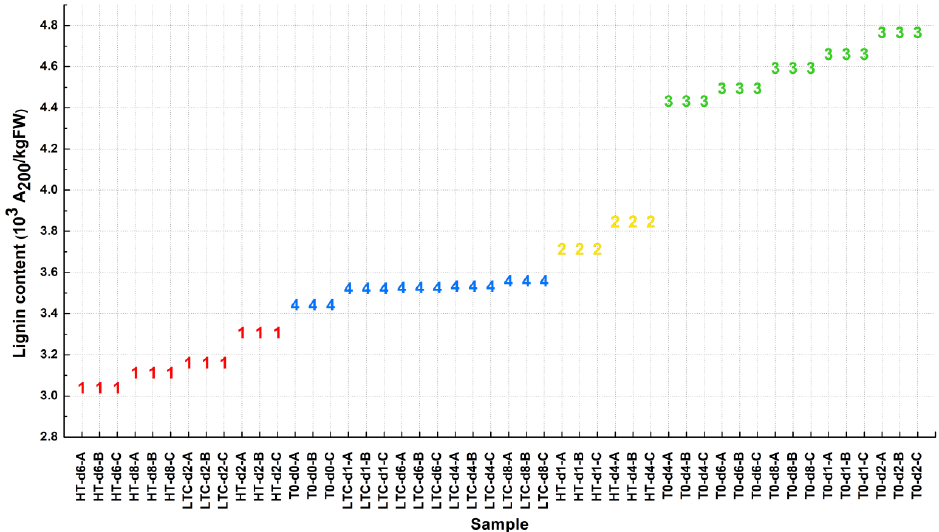
Figure 3. The k- means cluster result of the 48 loquat fruit samples from MATLAB. The number of groups was set to 4 in the k- means function. The data points are clustered based on the value of lignin content. (HT: heat treatment, LTC: Low temperature conditioning and T0: 0 °C).